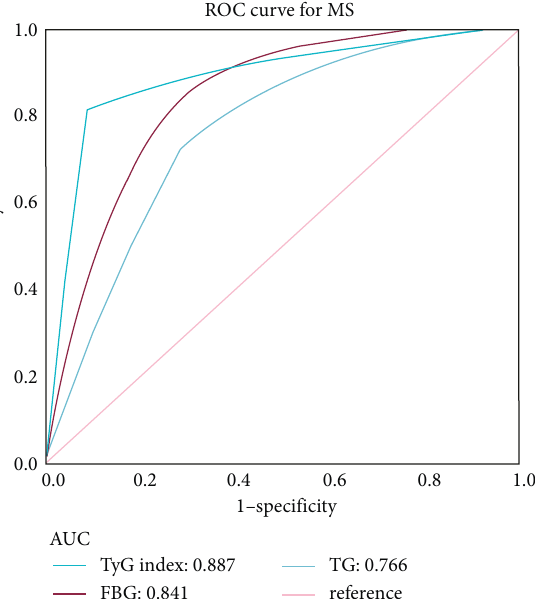
Figure 2: Receiver operating characteristic curve analyses for predicting MS. AUC, area under the curve; TyG, triglyceride-glucose; FBG, fasting blood glucose; TG, triglyceride. Table 5: Areas under the receiver operating characteristic curves for TyG index, FBG, and TG in identifying MS. Variables